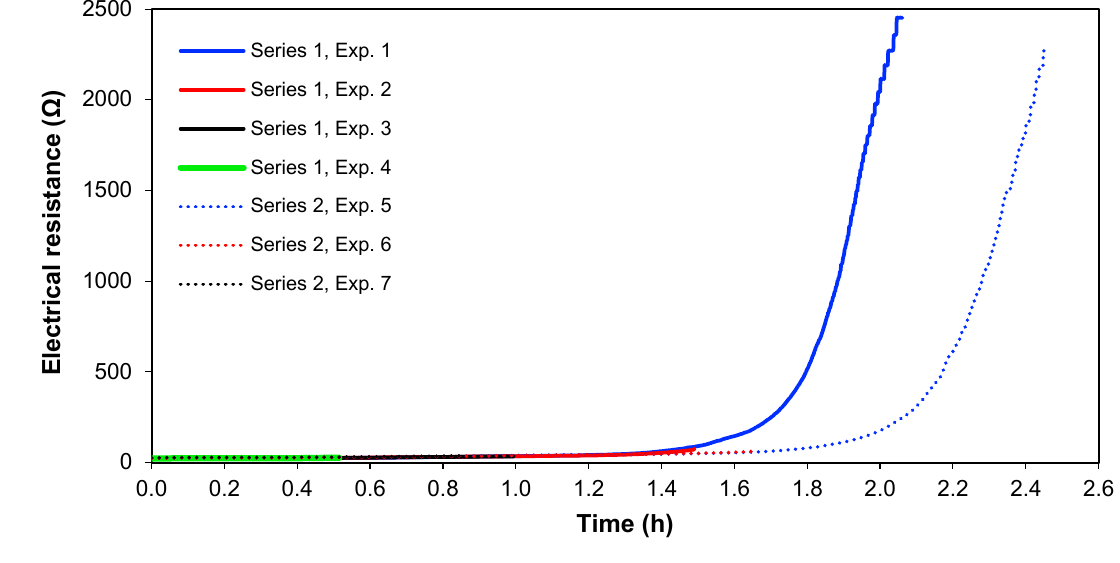
Figure 8. Electrical resistance across the cell with time.